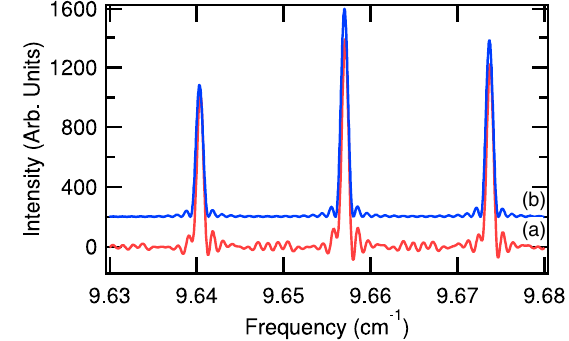
FIG. 5. (a) Spectral peaks from Fig. 4(a) in fine detail. (b) The line-shape based on the superradiant factor in Eq. (5), calculated (cid:1) N ¼ 16 as explained in the text and multiplied by the low- for b resolution spectrum and normalized to the peak height. The (cid:1) N Þ (cid:8) 0 : 0010 cm (cid:1) 1 agrees well predicted peak width 1 = ð T b with the data (offset for